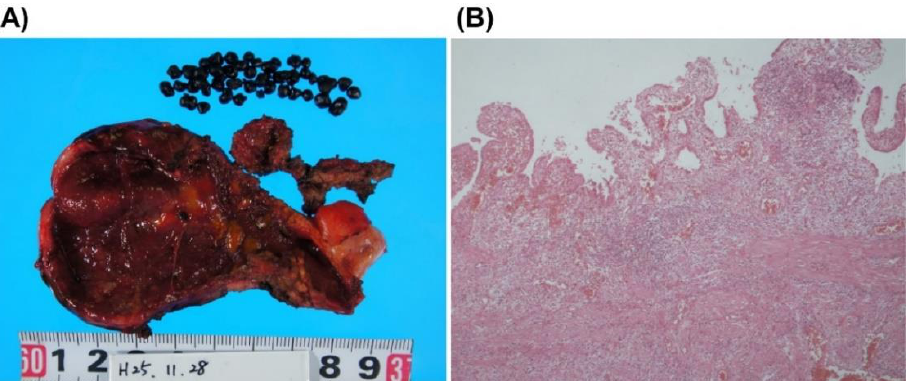
Figure 3. Macroscopic and microscopic findings of the gallbladder. ( A ), Macroscopic finding of the resected gallbladder. More than 30 black stones of 2 – 3 mm in diameter were found in the gallblad- der. The base of the gallbladder was partially melted due to necrotizing cholecystitis and abscess. ( B ), Microscopic findings revealed erosion, fibrosis, and moderate inflammatory cell infiltration with neutrophils, but no malignant cells.